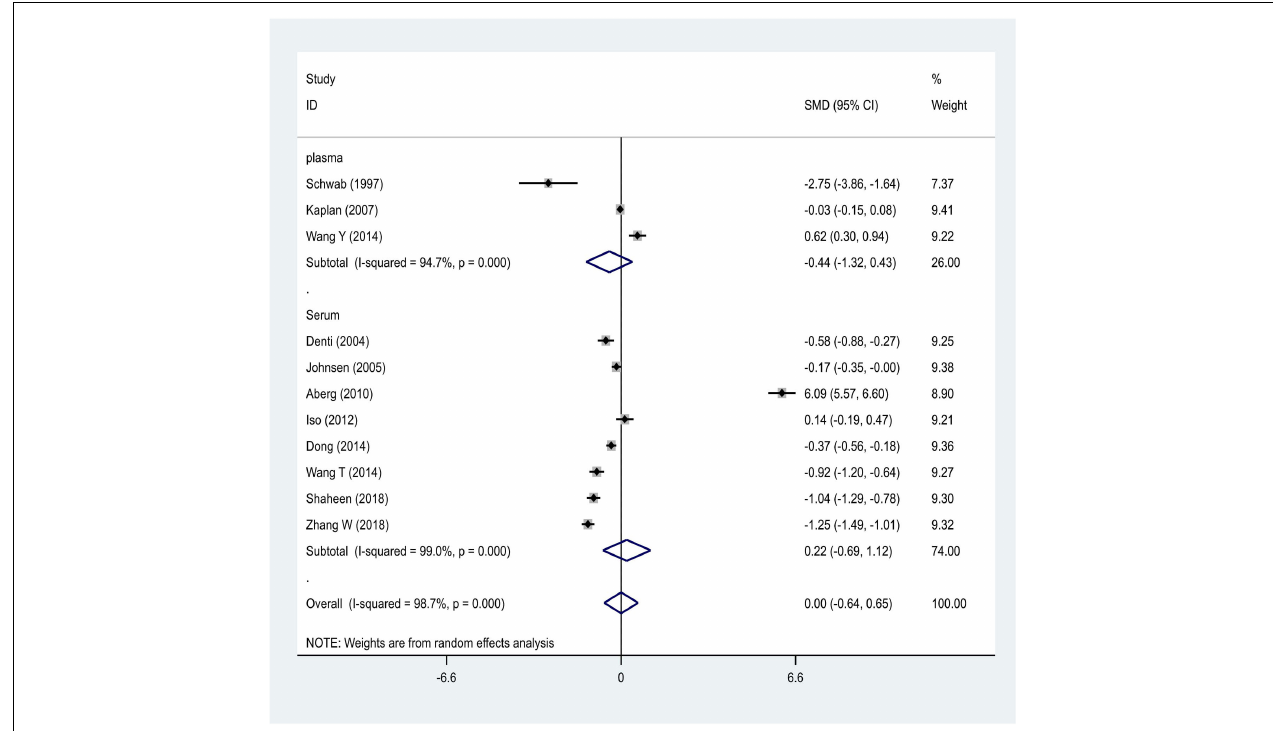
FIGURE 9 | Results of meta-analysis for the IGF-1 level in plasma and serum, respectively.